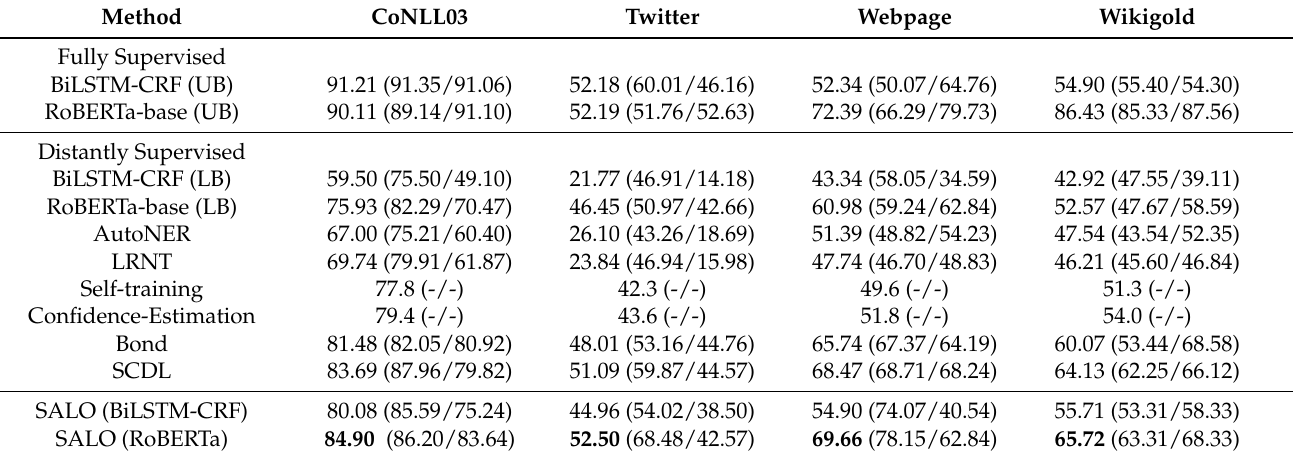
Table 1. Performance of all methods on four datasets measured by F 1 score (Precision/Recall) (in %). Base models directly trained using clean labels and noisy ones can be referred as upper bound (marked with UB) and lower bound (marked with